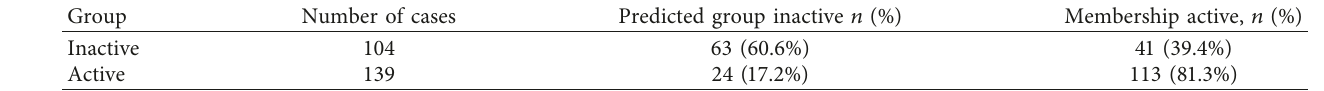
Table 4: Classification results of the discriminant